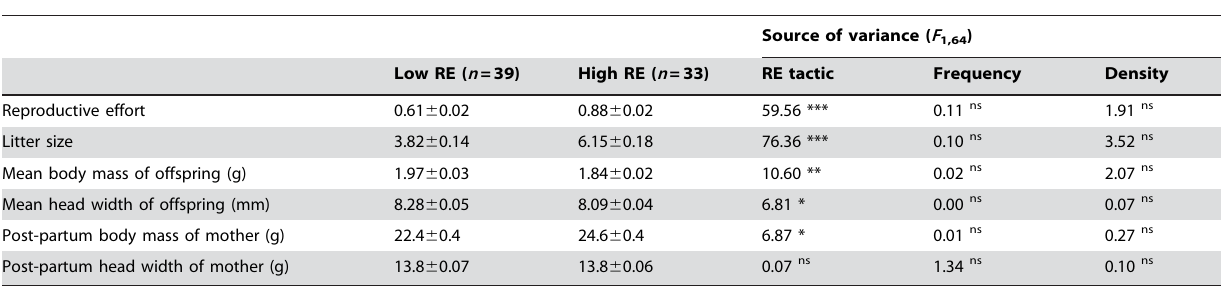
Table 3. Characteristics (mean 6 SE) of two female tactics (low or high reproductive effort, RE).